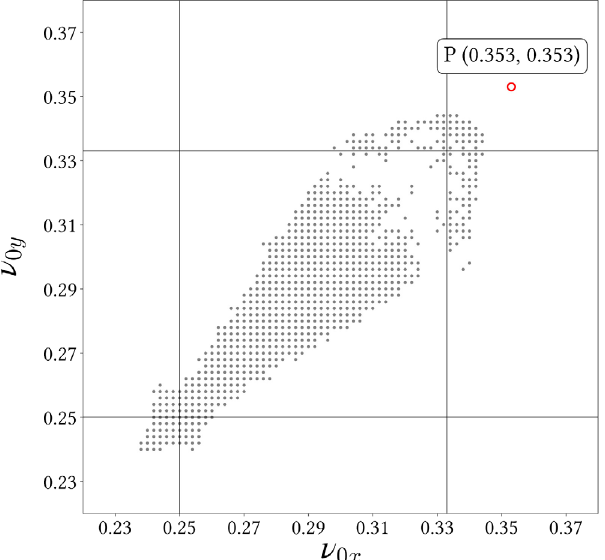
FIG. 21. Example of the incoherent tune spread of a Gaussian beam with η ¼ 0 . 8 (2D W ARP result). The beam transport distance is extended to 1000 AG periods (see Fig. 22). The operating point is set at ð ν 0 x ; ν 0 y Þ ¼ ð 0 . 353 ; 0 . 353 Þ . The single- particle trajectories near the end of the transport channel are Fourier analyzed to figure out the incoherent tune spread. The single-particle resonance lines of the third and fourth orders, i.e., ν